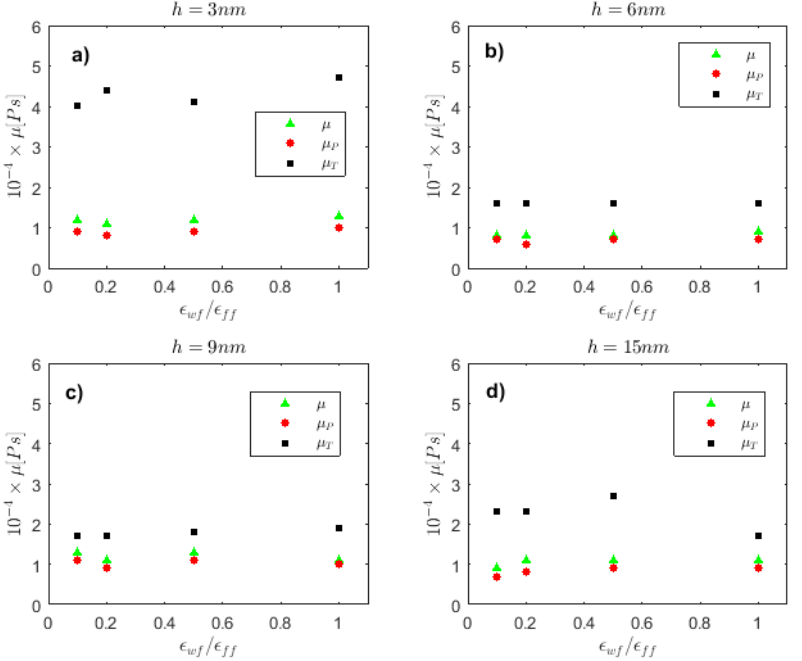
Figure 3. Shear viscosity vs. the wall wettability strength, ε wf / ε f f , for ( a ) h = 3 nm, ( b ) h = 6 nm, ( c ) h = 9 nm, and ( d ) h = 15 nm. E = 0.1 V/Å.